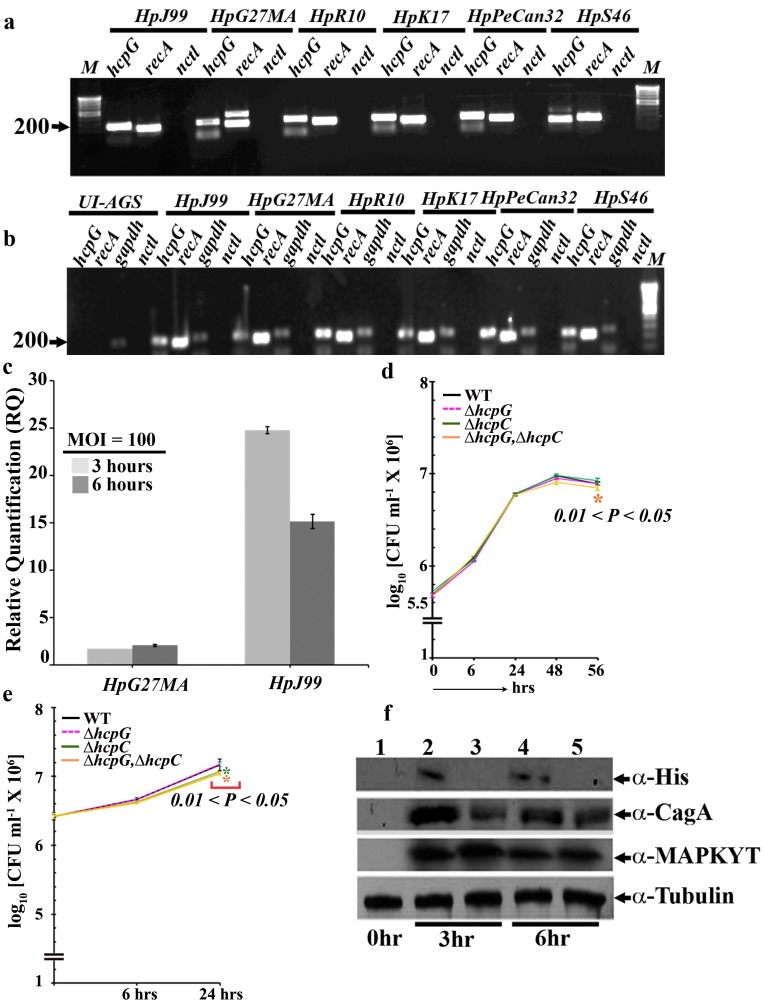
Biological relevance of hcpG during H. pylori growth and infection.(a) RT-PCR amplification of hcpG transcripts from 24 h growth in pure broth cultures. recA, positive control; nctl, negative control, in which extracted RNA was used as a template for RT-PCR. The geographic origins of the strains used were as follows: HpJ99, United States; HpG27MA, Italy; HpR10, South Africa; HpK17, South Korea; HpPeCan32, Lima, Peru; and HpS46, Spain. (b) RT-PCR amplification of hcpG transcripts in cultured AGS cells 6 h after infection (multiplicity of infection [MOI] = 100). gapdh was included as a positive control for AGS cell transcription in addition to the controls listed in Fig. 3a. UI, uninfected. (c). Quantitative RT-PCR analysis of hcpG transcripts in cultured AGS cells 3 and 6 h after infection with HpG27MA and HpJ99, respectively. The results show the averages from three experiments (± standard error of the mean). (d) Growth curves of WT HpG27MA and hcpG and/or hcpC derivatives in pure broth cultures; the results show averages from three experiments (± standard deviation [SD]). (e). Growth curves of WT HpG27MA strain and hcpG and/or hcpC deletion derivatives during infection of cultured AGS cells. The results show the averages from five experiments (± SD). (f). Verification of HcpG synthesis during infection of cultured AGS cells with the HpG27MA derivative expressing the HcpG::6xHis fusion protein; Lane 1, uninfected AGS cells (control); lanes 2 and 3, 3 h after infection with HpG27MA::HcpG-6XHis and HpG27MAΔhcpG, respectively; lanes 4 and 5∶6 h after infection with HpG27MA::HcpG-6XHis and HpG27MAΔhcpG, respectively. α-Tubulin was used as a measure for equal gel loading. CFU, colony-forming unit.